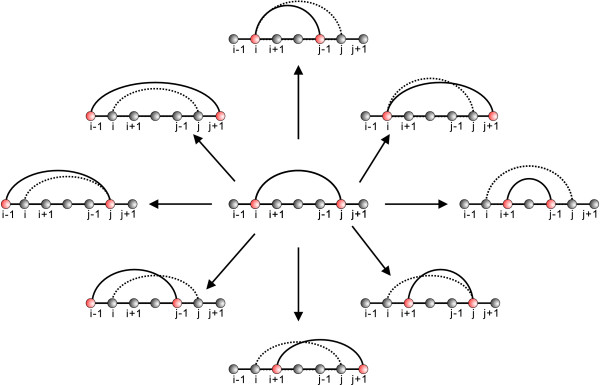
Perturbations. Nine perturbations of an arc (i, j). Original arcs are drawn dotted, and the arcs incident to red bases are the perturbations.